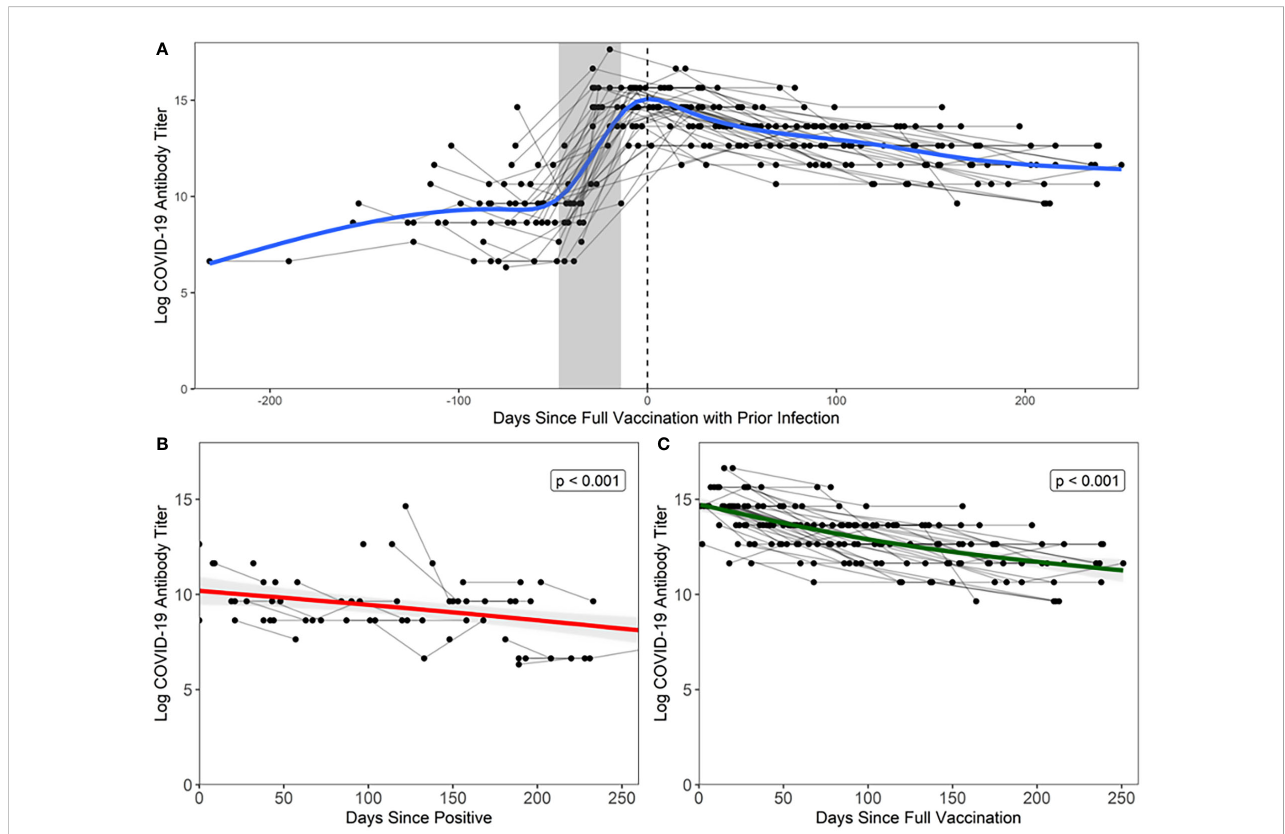
FIGURE 1 Antibody response following natural infection and vaccination Each black point represents a sample from a participant, grey lines connect points from the same participant, and the grey shaded area represents the maximum number of days between doses relative to date of full vaccination (14 days after second dose, regardless of vaccine manufacturer). (A) Days since full vaccination vs . log titers over time. t=0 on the x-axis represents the day when COVID+ participants became fully vaccinated (2 weeks after second vaccination). Bi-phasic, generalized additive model (GAM) is visualized by a blue line. (B) In unvaccinated COVID+ participants, log 2 antibody titers decay at a rate of -0.010 per day after last positive COVID-19 test result. Fitted linear model is visualized by a red line. Note that three points were excluded from the above fi gure due to the temporal scale used to graphically depict the data but are included in the analyses herein. (C) In vaccinated COVID+ participants, log2 antibody titers decay at a rate of -0.015 per day after full vaccination. Fitted linear model is visualized by a green